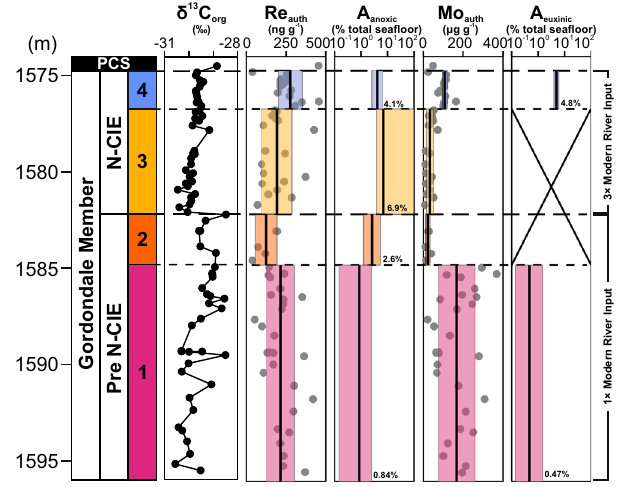
Fig. 3 | Rhenium and molybdenum mass balance model results based on Gor- dondaleMemberauthigenicmetalenrichmentstodeterminesea fl oorareasof anoxia (A anoxic ) and euxinia (A euxinic ) prior to and during the Toarcian Oceanic Anoxic Event (T-OAE). All model results were determined using a bulk mass accumulation rate calculated from the median duration of the T-OAE (400 kyr) 3 – 5 . Pre-N-CIEmodelresults(modelintervals,MI-1andMI-2)weredeterminedwithriver inputs set to modern (4.29 × 10 5 mol Re yr − 1 ; 3.00 × 10 8 mol Mo yr − 1 ) 18,19,33 , while N-CIE intervals (MI-3 and MI-4) were determined with river input set to 3-times modern 11 . No results for the Mo mass balance modeling are presented for MI-2 or MI-3becausetheminimalenrichmentsindicatelocalredoxconditions(non-euxinic anoxicorsuboxidizing)thatdonotre fl ectchangestotheglobaldissolvedseawater Mo reservoir. Mean values are shown as solid black lines, bracketed by 1 standard deviation shaded boxes. Abbreviations: m, meters; PCS, Poker Chip Shale; N-CIE, negative carbon isotope